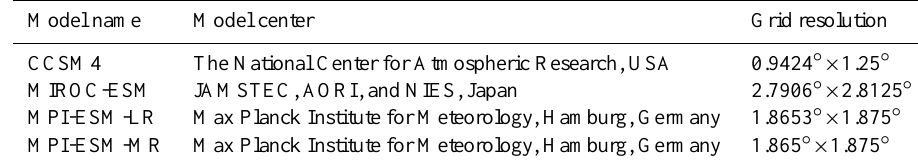
Table 2. Information of the climate models.